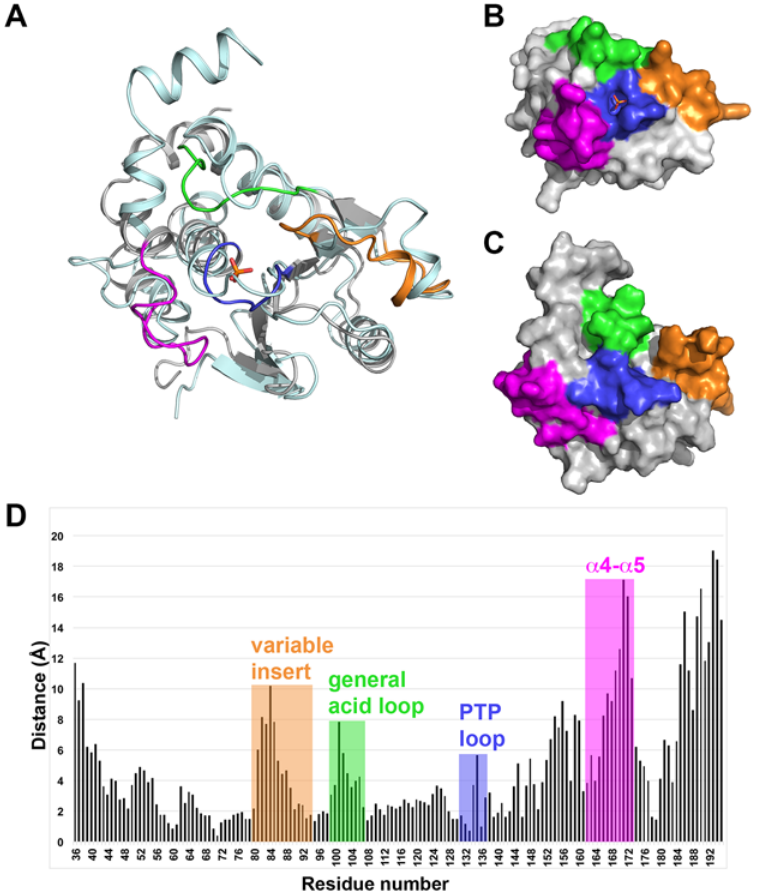
Fig 4. Comparison of TpbA in the ligand-bound and ligand-free state. A: Superposition of TpbA in the ligand-bound and ligand-free states. Ligand-bound TpbA is coloured grey and functionally important loops are coloured as described in Fig 2. Ligand-free TpbA is coloured pale cyan. B and C: Surface representations of TpbA in the ligand-bound and ligand-free (PDB ID: 2M3V) states, respectively. Functionally important loops are coloured as described in Fig 2. D: Histogram showing the distance ( Å ) between equivalent residues in the ligand-bound and ligand-free